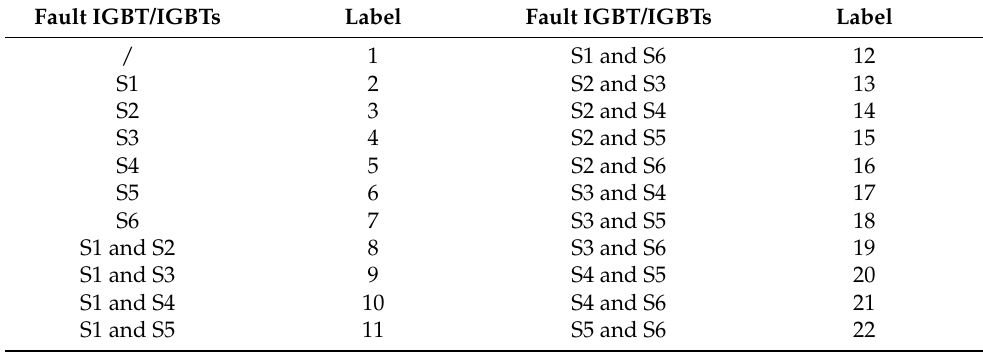
Table 1. IGBT open-circuit fault label.